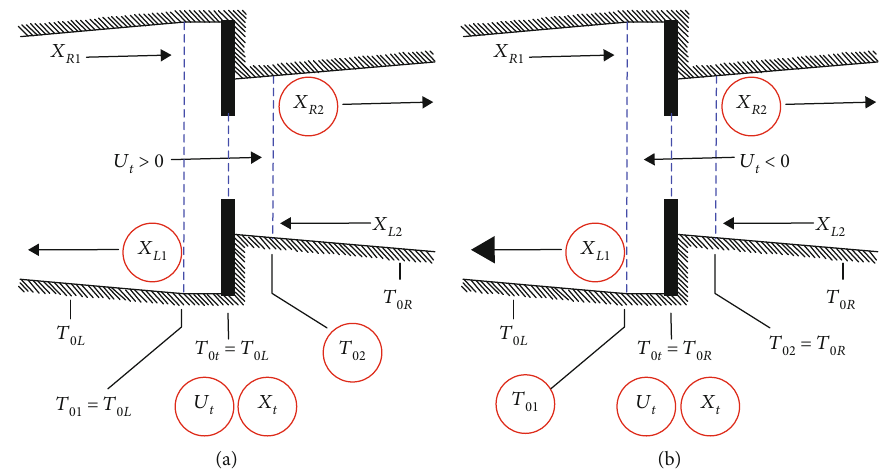
Figure 5: (a) Forward and (b) reverse parameter constraints for adjoined pipe boundary (unknowns are